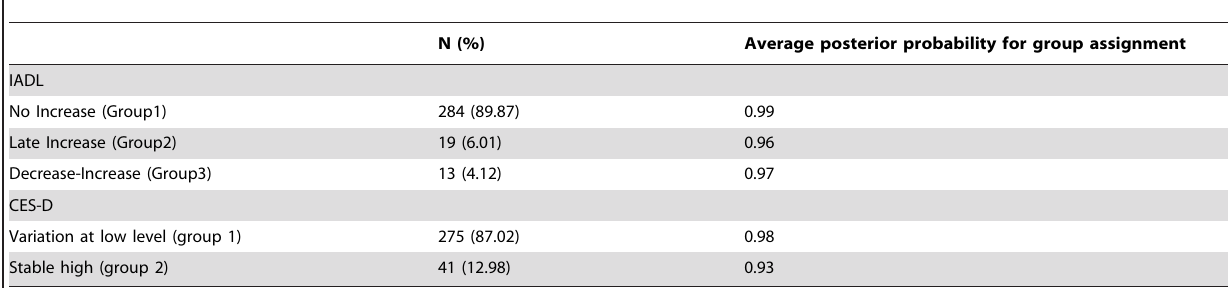
Table 2. Percentages of the sample assigned to each trajectory group and average posterior probability for trajectory assignment.